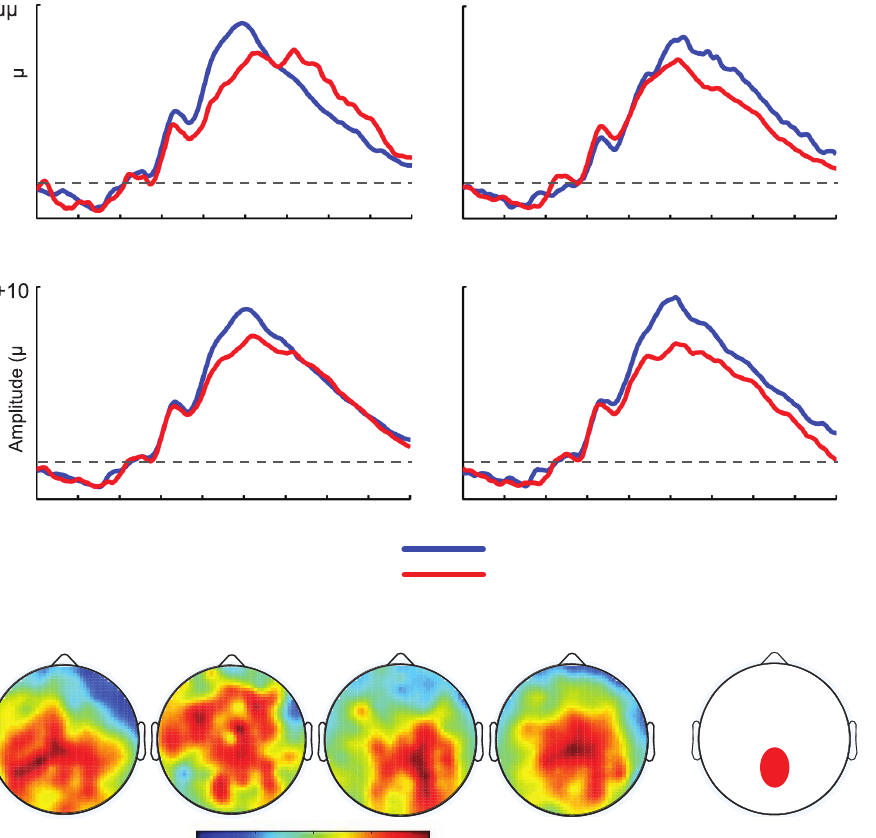
Figure 4. Neutral condition ERPs. Averaged ERP waveforms for the Feedback-Related Negativity (FRN) plotting ERPs to Wins and Losses in the neutral blocks.